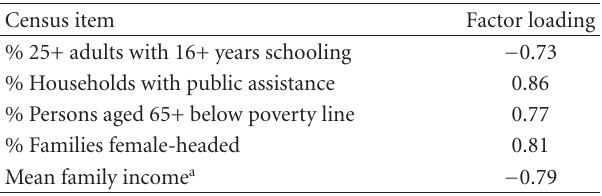
Table 3: Principal components factor analysis of Neighborhood Socioeconomic Disadvantage